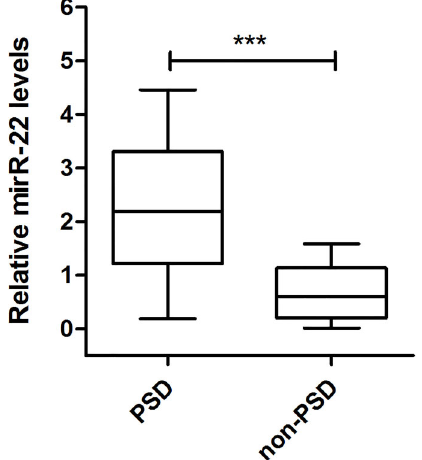
Figure 2. Relative expression of miR-22 in plasma compared between the post-stroke depression (PSD) group and the non- PSD group. Data are reported as median and interquartile range. ***P o 0.001 (Mann-Whitney U-test).